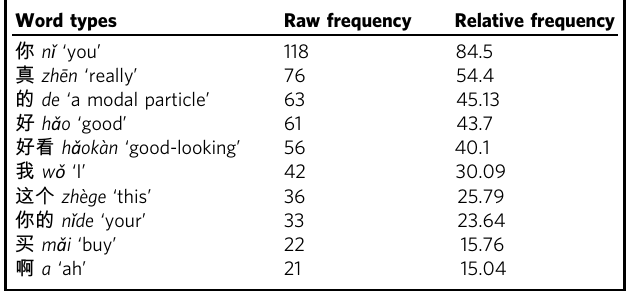
Table 7 Most frequent adjectives in boys ’ normal speech style.